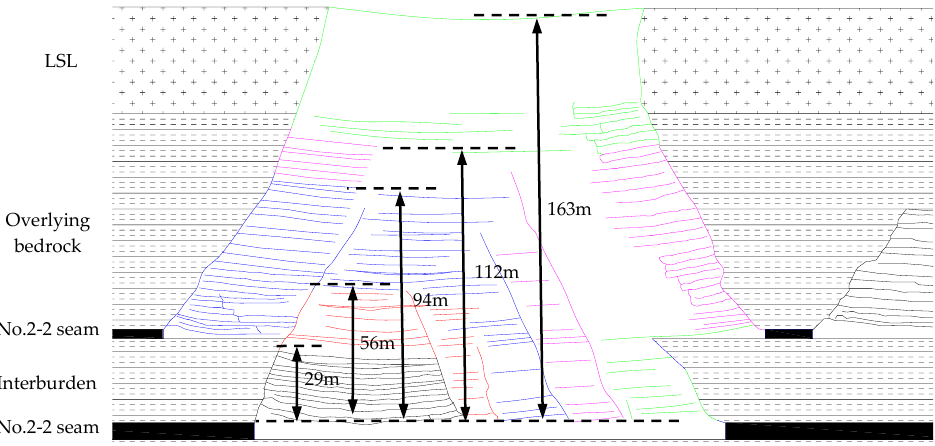
Figure 16. N1206 working face DPC activation development schematic diagram.